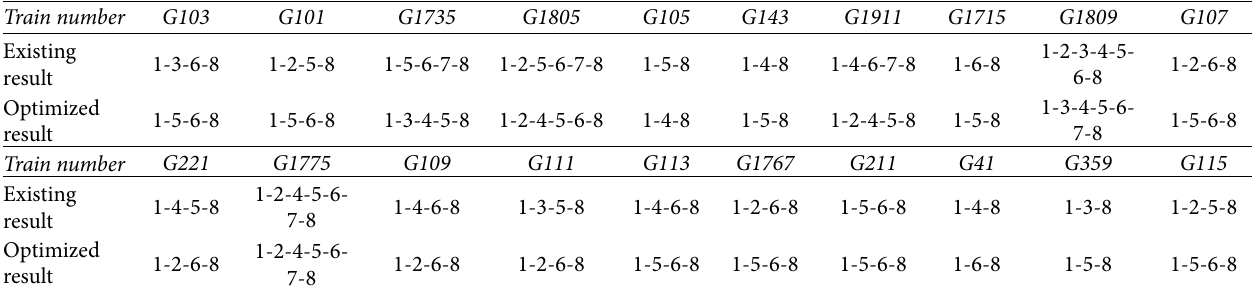
Table 3: Comparisons on the train stop schedule.